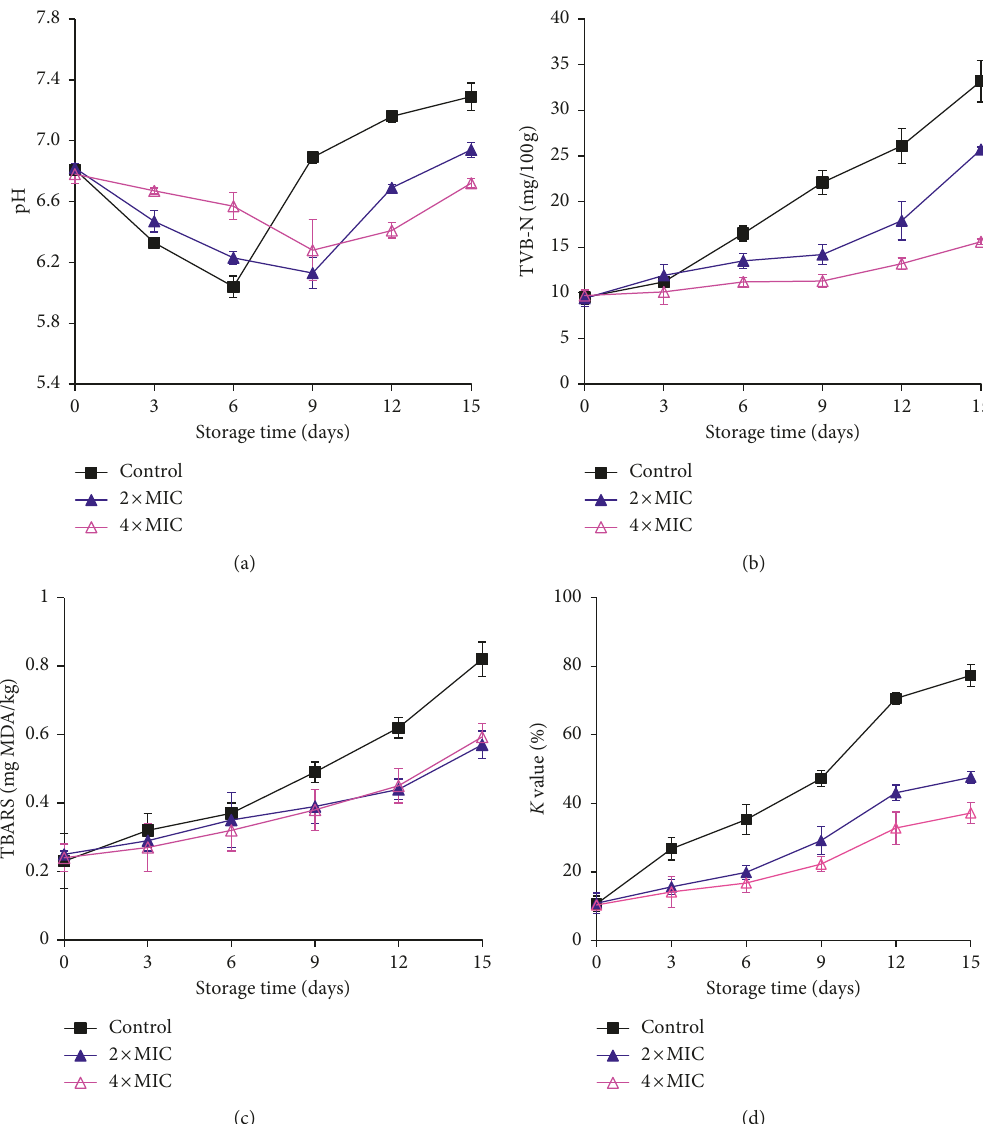
Figure 3: Changes in pH (a), TVB-N (b), TBARS (c), and K -value (d) of chilled mackerel fillets packed with the films incorporated without/ with 2 MIC and 4 MIC bifidocin × ×